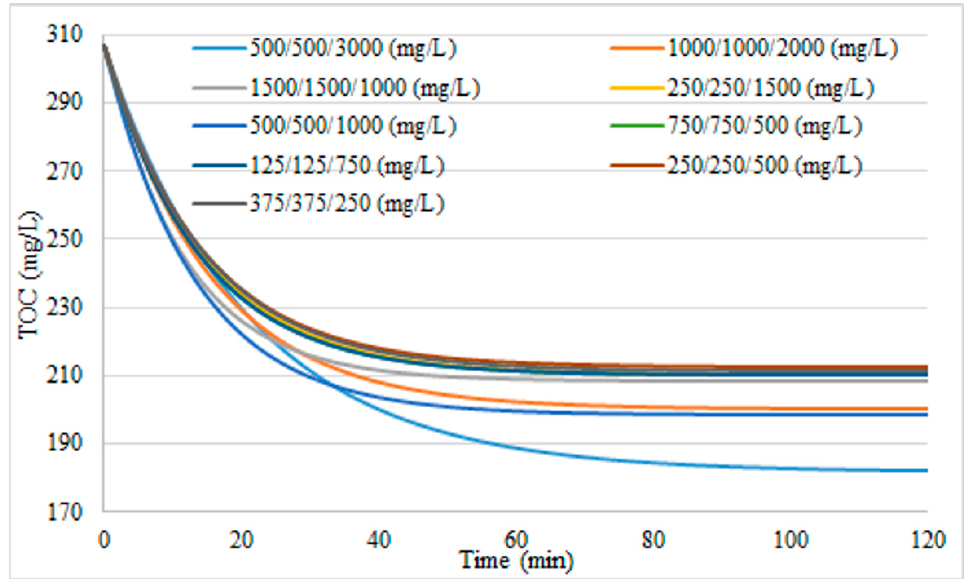
and the lowest for 1000 mg/L. In most cases, lower values of TOC were recorded for the lower 1:1 H 2 O 2 /COD ratio. The TOC values determined after the treatment process with the 2:1 H 2 O 2 /COD ratio were higher than the value for 1:1 H 2 O 2 /COD ratio. The exception was the process involving 1000 mg/L of hematite, 1000 mg/L of magnetite, and 2000 mg/L of metallic iron, in which the difference was 40 mg/L.